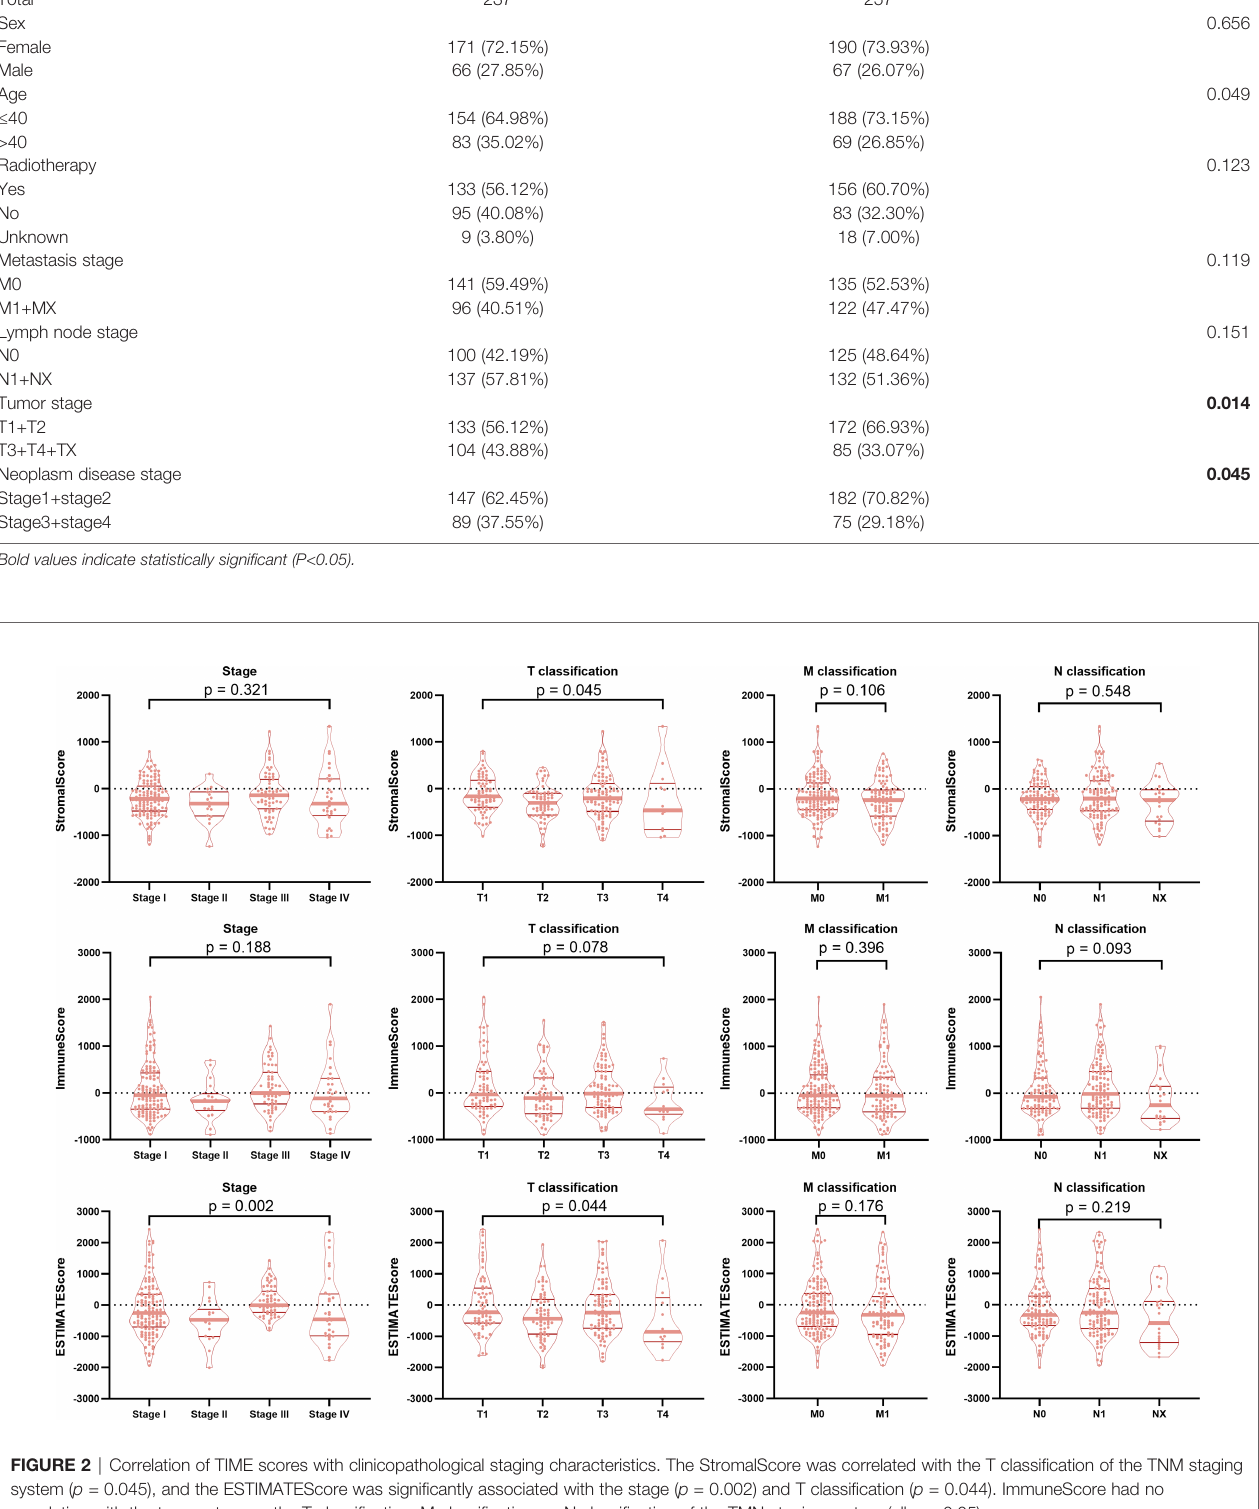
TABLE 1 | Characteristics of the BRAF-mutated PTC patient cohort.